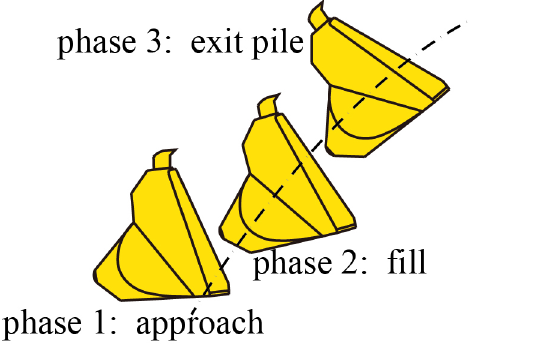
Figure 2. The three phases in the scooping